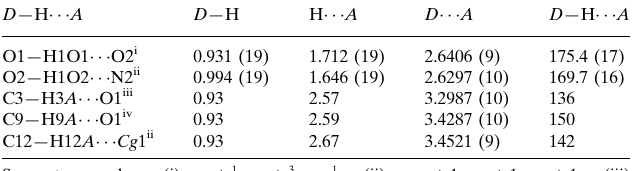
Hydrogen-bond geometry (A˚ , (cid:2)